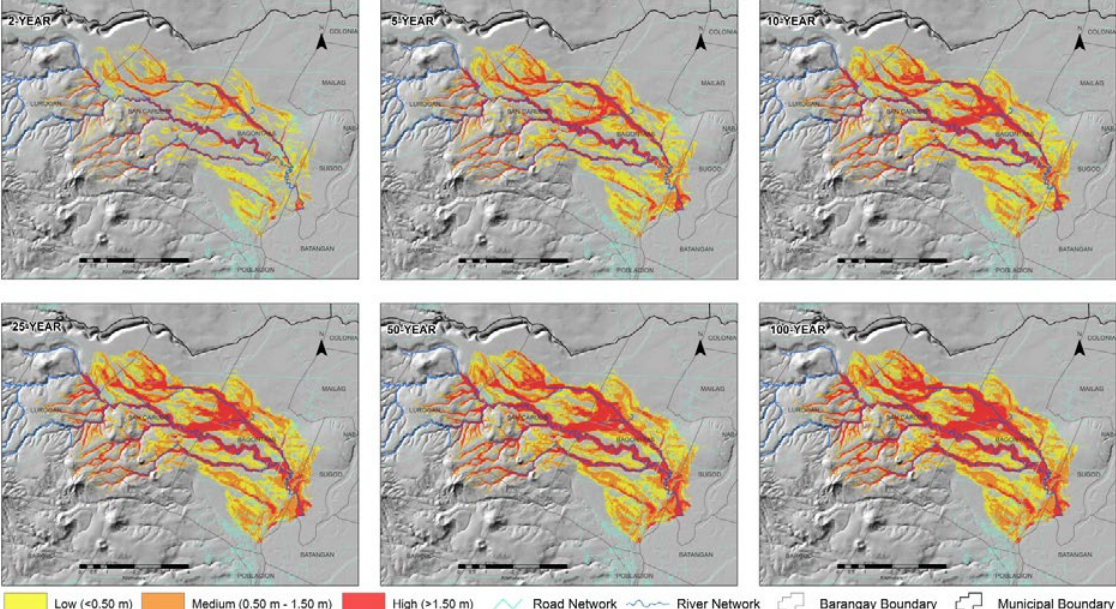
Fig. 9: Flood hazard maps of Malingon River in different return periods